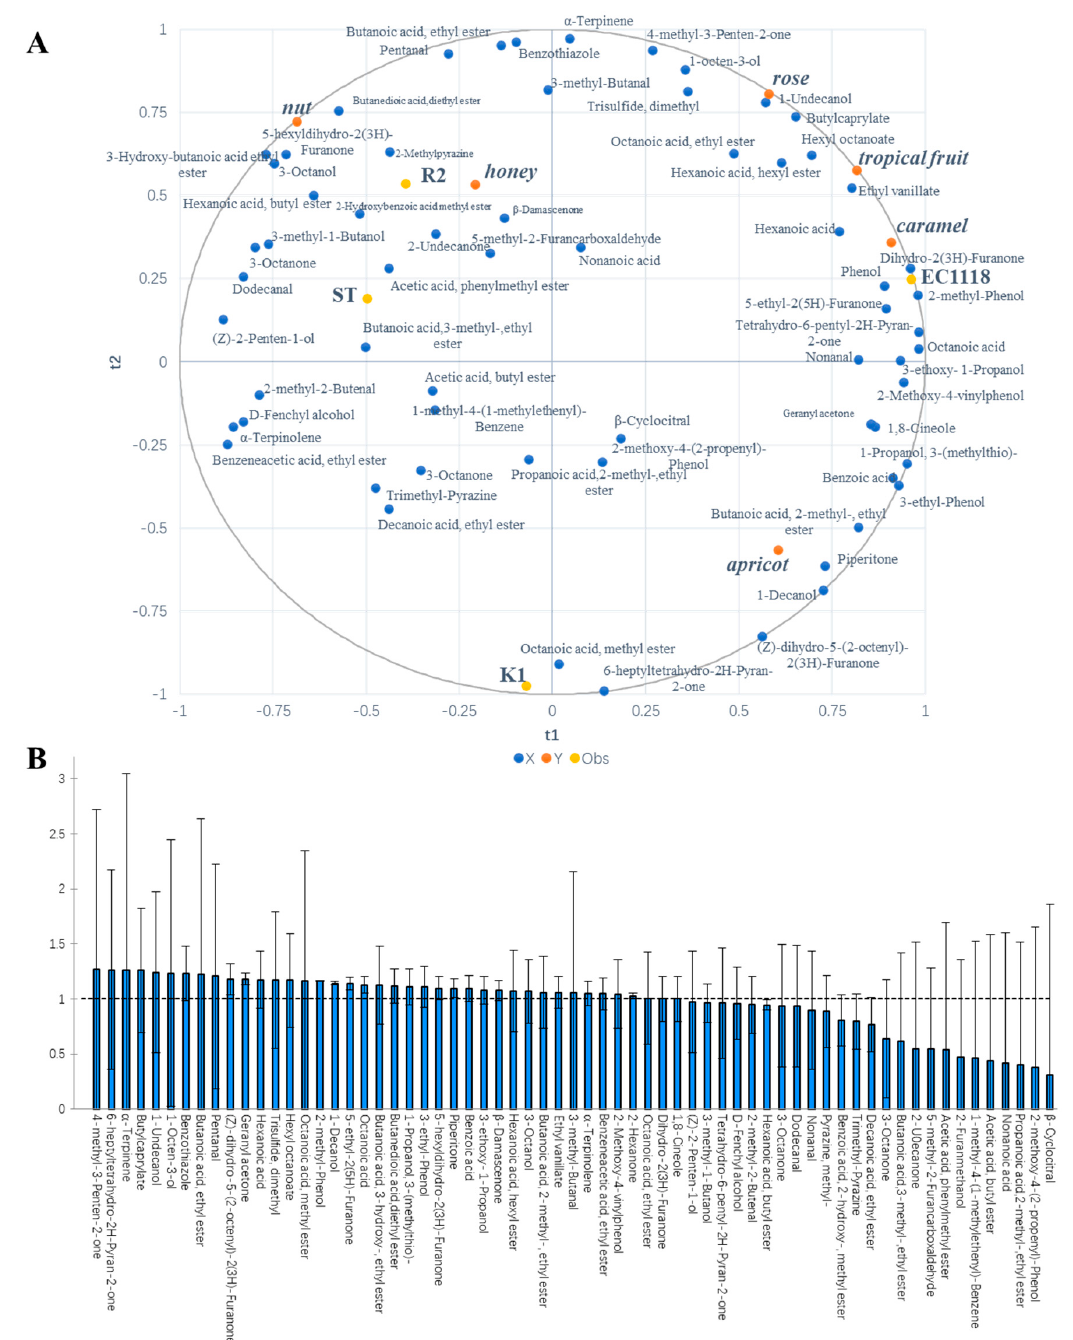
Figure 3. Projection on the PLS regression between sensory attributes and aroma compounds ( p < 0.05) of four different yeast fermented icewines ( A ); the VIP values were calculated from the PLS regression model ( B ).